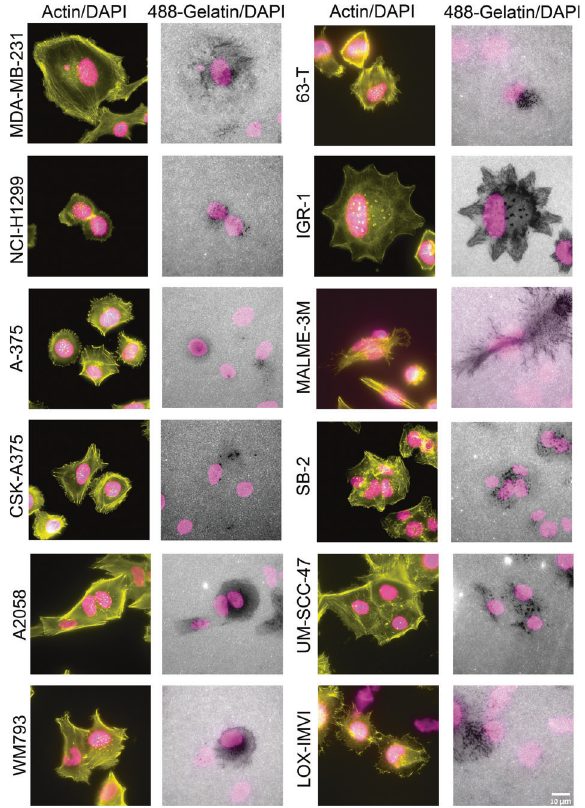
Fig. 1 A panel of multi-cancer cell lines screened for gelatin degradation and actin-rich invadopodia structures. Cell lines were cultured on a fl uorescently labeled (488) gelatin and cultured for 5 – 6 h. Subsequently, the cells were fi xed and stained for actin (TRITC-phalloidin) and DAPI. Images were acquired under 60×/1.42 oil objective. Among the 21 multi-cancer cell line panel used in the study, 12 cancer cell lines (shown here) were found to be positive for the actin-rich invadopodia appearing as prominent actin-rich dots near the nucleus and gelatin matrix degradation. Scale bar is 10 µm.